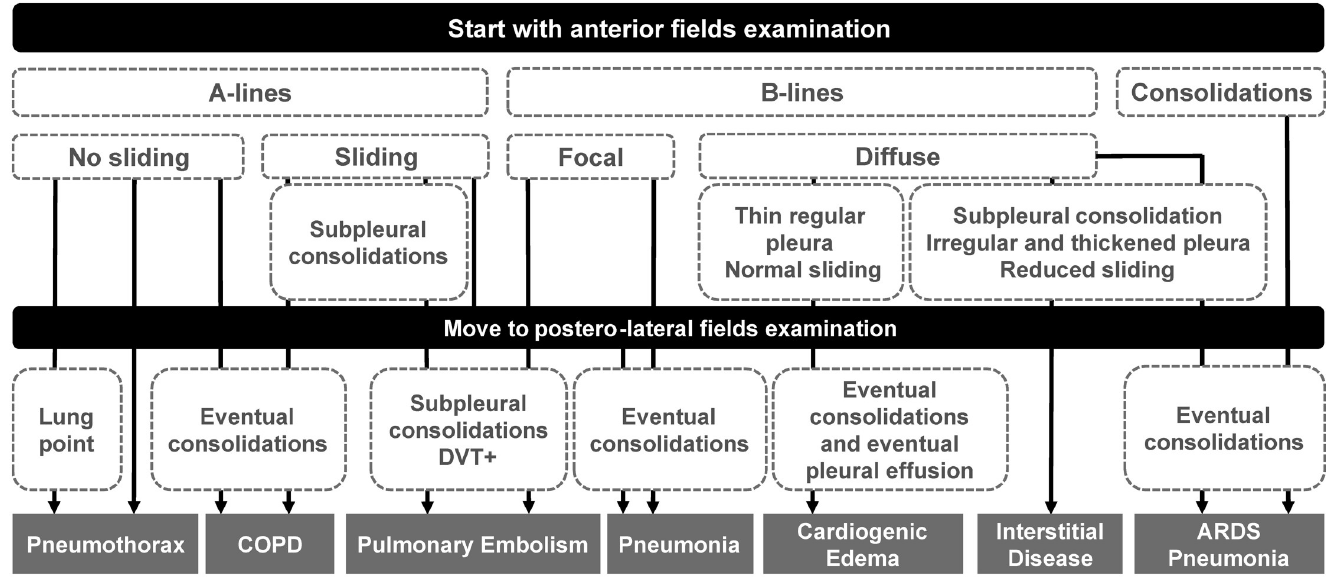
Fig 2. Flowchart for systematic diagnosis of lung diseases by means of LUS. (DVT—Deep Venous Thrombosis).